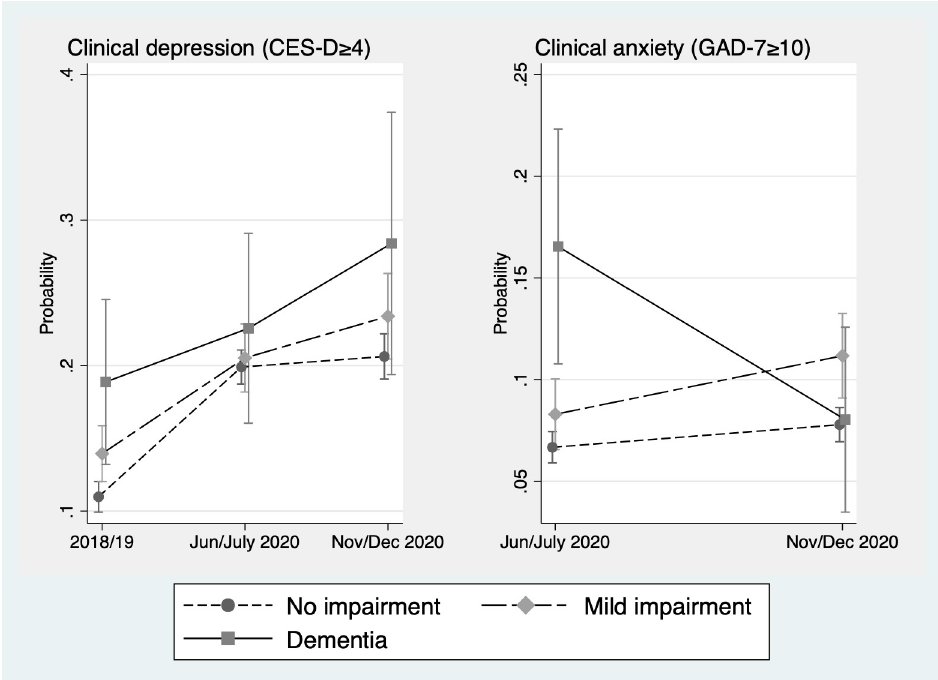
Fig 4. Likely clinical depression and anxiety over time by cognitive function (estimated probabilities and 95% confidence intervals, adjusted for all available covariates).